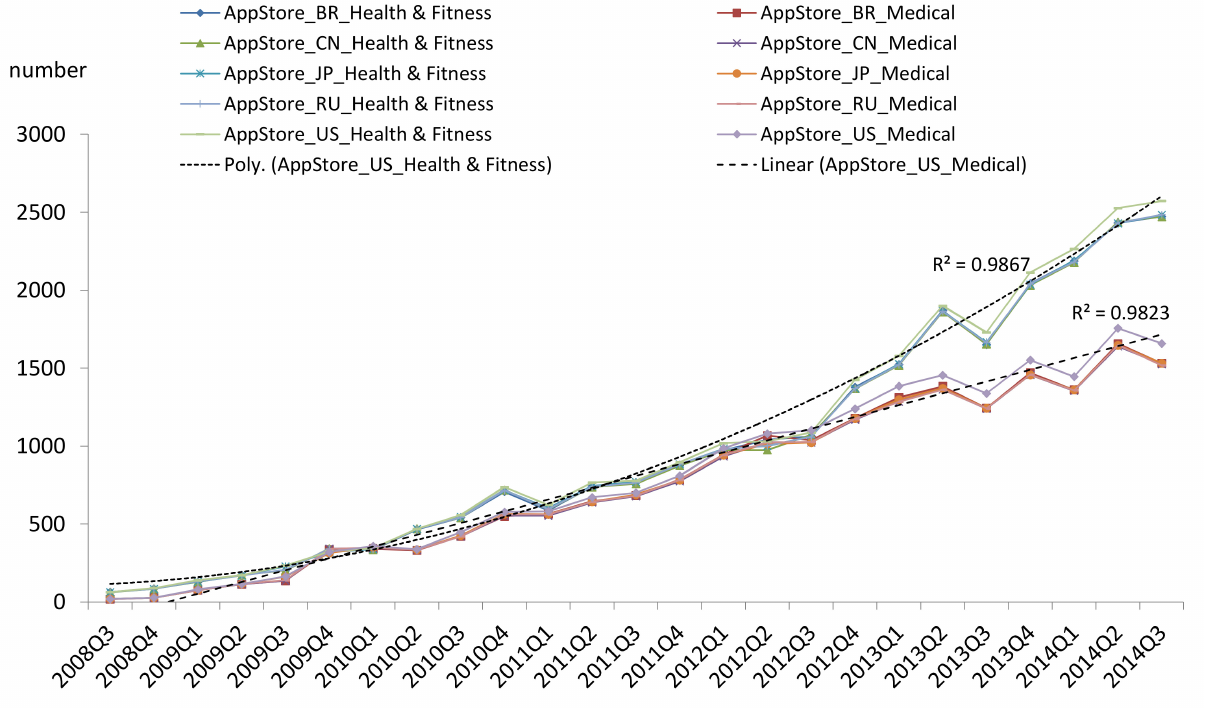
Figure 1. The trend of the number of released mHealth apps in the Apple App Store (AppStore). 2008Q3: third quarter of year 2008. BR: Brazil; CN: China; JP: Japan; RU: Russia; US: United